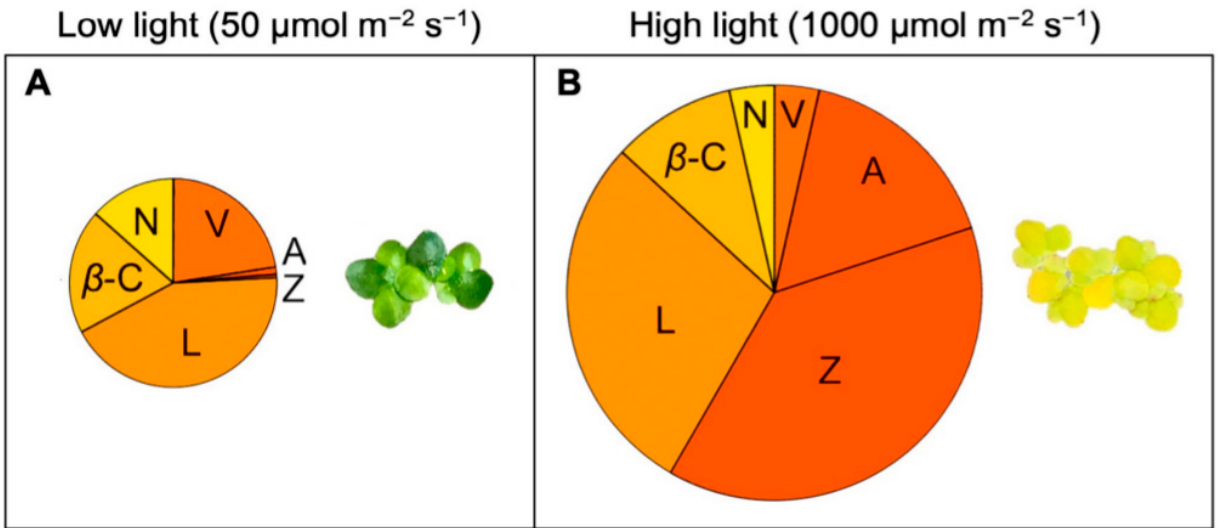
Figure 4. Carotenoid composition of Lemna gibba grown under continuous ( A ) low or ( B ) high light intensity. The size of the respective pies represents the molar ratio of the sum of all carotenoids to chlorophyll. Data from [24]; adapted from [16]. A, antheraxanthin, β -C, β -carotene, L, lutein, N, neoxanthin, V, violaxanthin, Z, zeaxanthin.